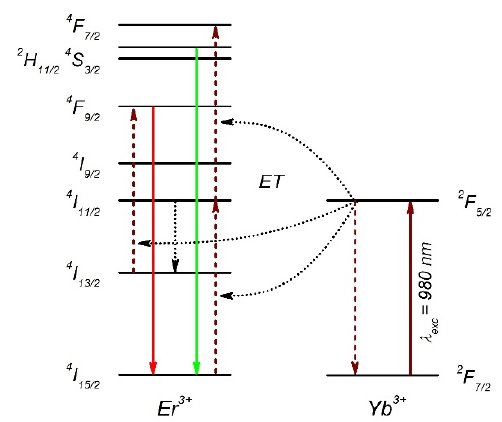
Figure 3. Simplified energy diagram of Er 3 + and Yb 3 + . Dotted arrows illustrate energy transfer and other non-radiative processes leading to the up-conversion photoluminescence (green and red lines).